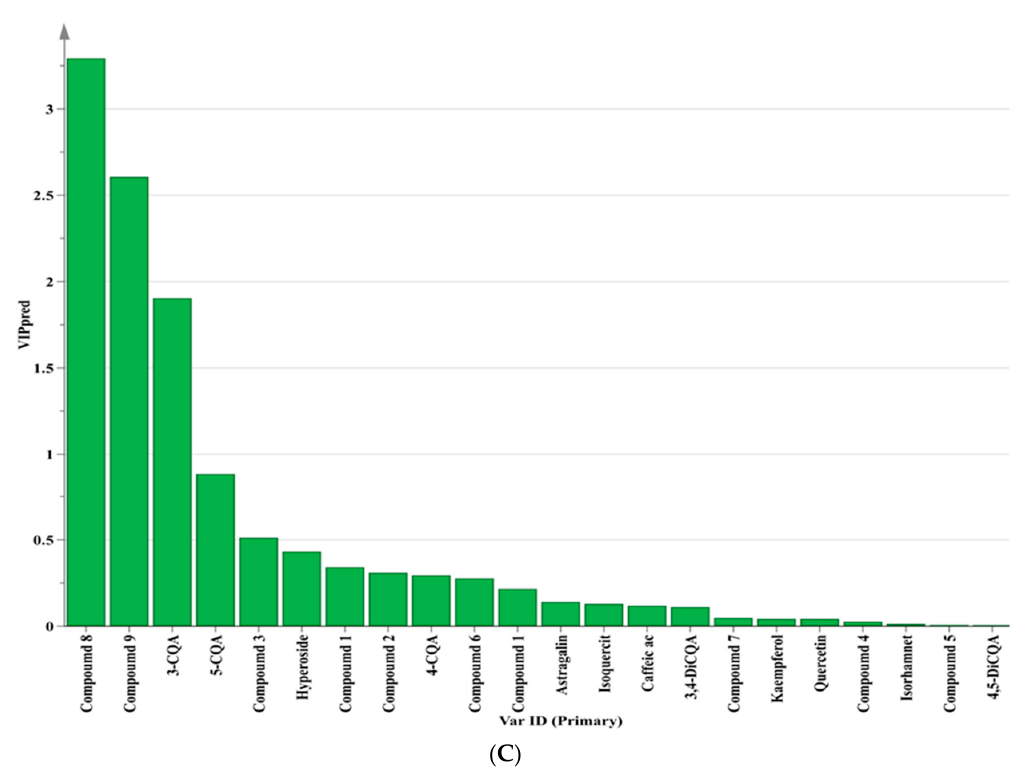
Figure 5. The score scatter plot (PLS-DA) ( A ), loading scatter plot (PLS-DA) ( B ), and VIP plot (PLS-DA) ( C ) of CS and PCS samples.